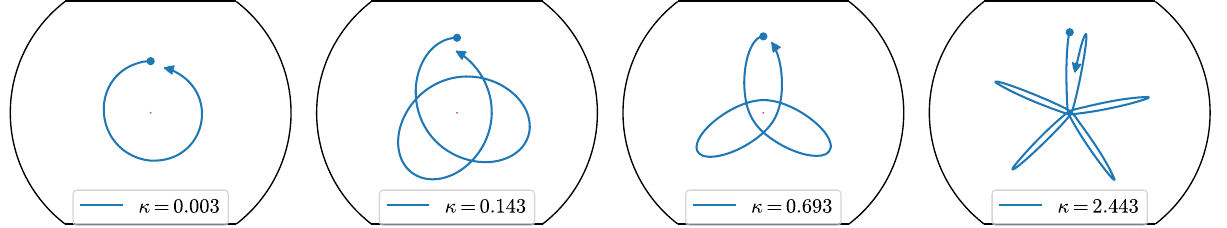
FIG. 7. Example of orbits in the logarithmic potential of the LHC beam for distinct shape parameters. As κ → 0 , the orbit becomes circular and for κ → ∞ , the orbit degenerates into a straight line going through the beam. S makes the orbit scale radially but does not change the shape. The beam screen has a width of 46.5 mm and a height of 36.9 mm.